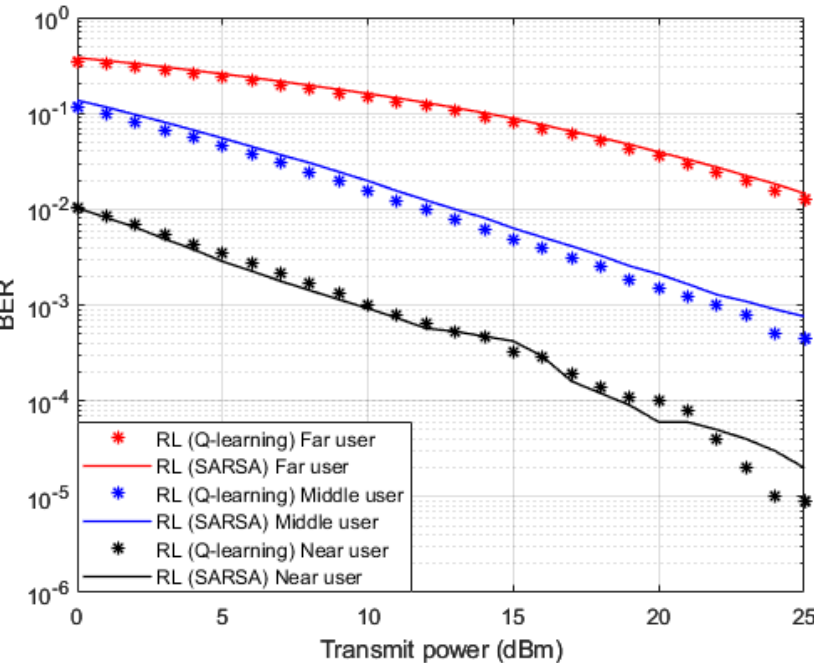
Figure 9. BER vs. power ( Q ‐ learning, SARSA).